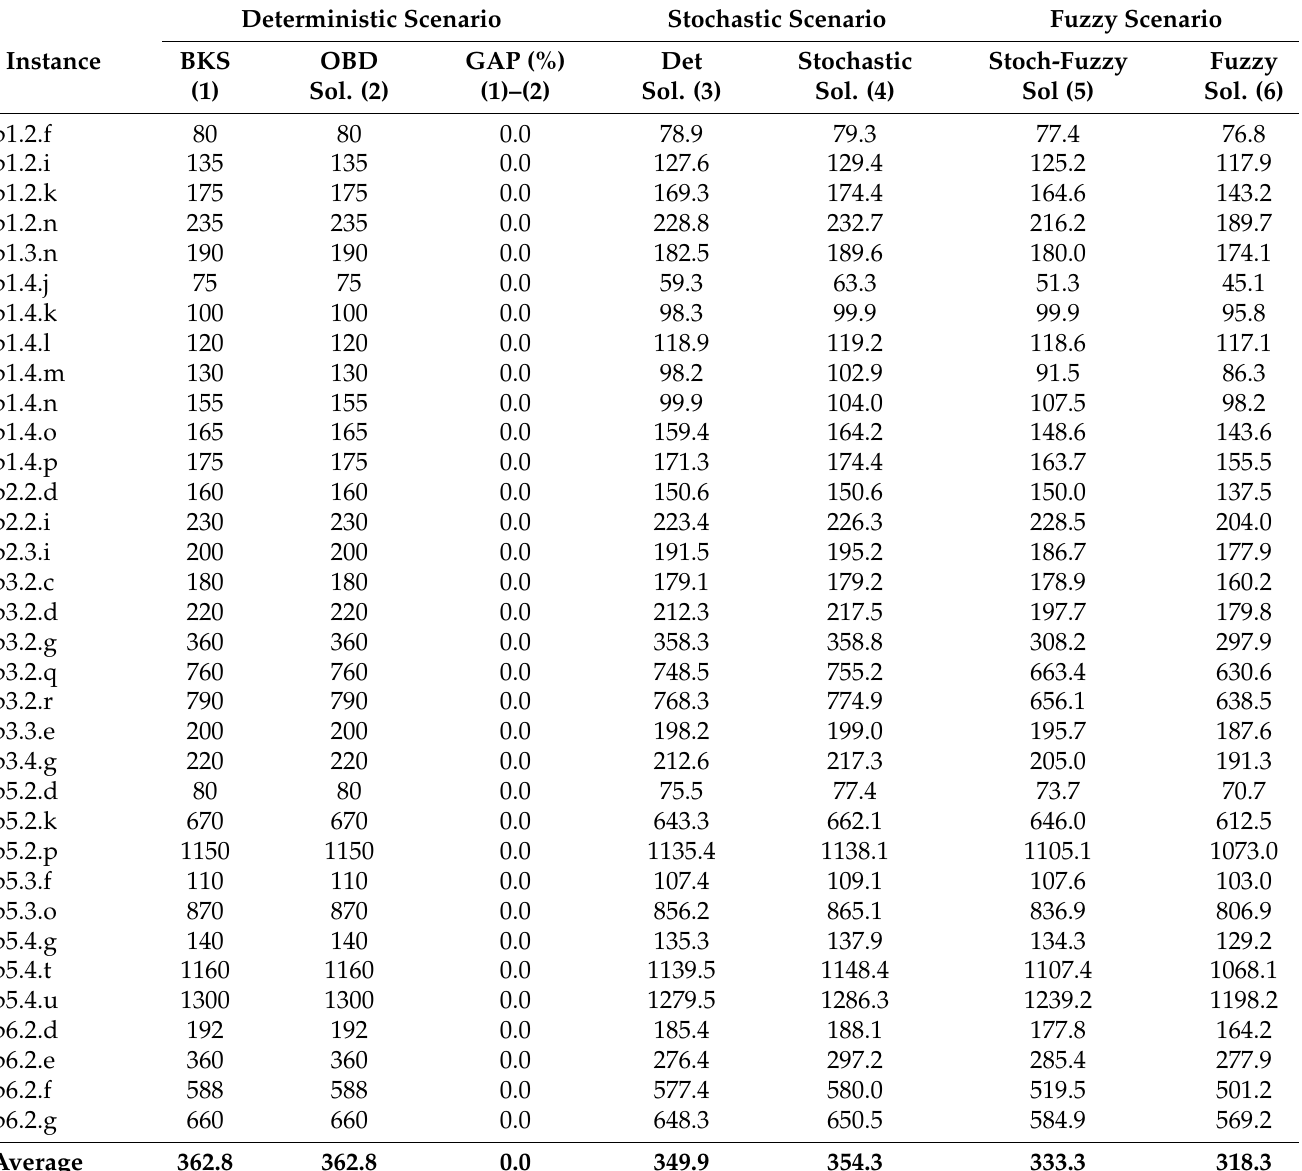
Table 4. Comparison of results, in terms of collected reward, for the different TOP